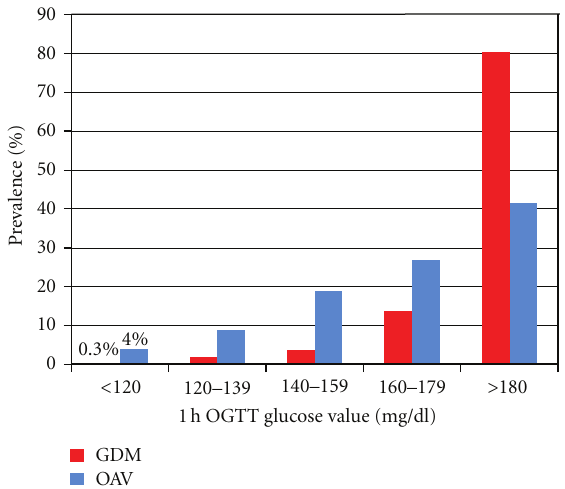
Figure 1: GDM and OAV prevalence according to 1-hour OGTT plasma glycaemia. GDM: gestational diabetes mellitus; OAV: wo- men with one abnormal value during OGTT. The prevalence of GDM and OAV increases in the five groups of pregnant women (both P < 0 .